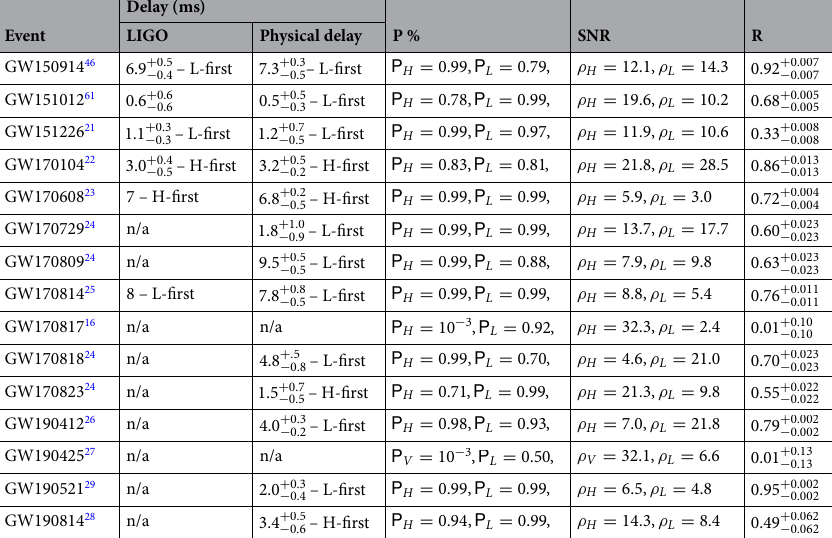
Table 1. Results of our approach for detection of fifteen GW candidates. n/a time delays in the LIGO column means the corresponding time delay for that GW event is not reported by LIGO, at least we were not able to find it. n/a in the physical delay column means we didn’t find a statistical meaningful time delay to report for that GW